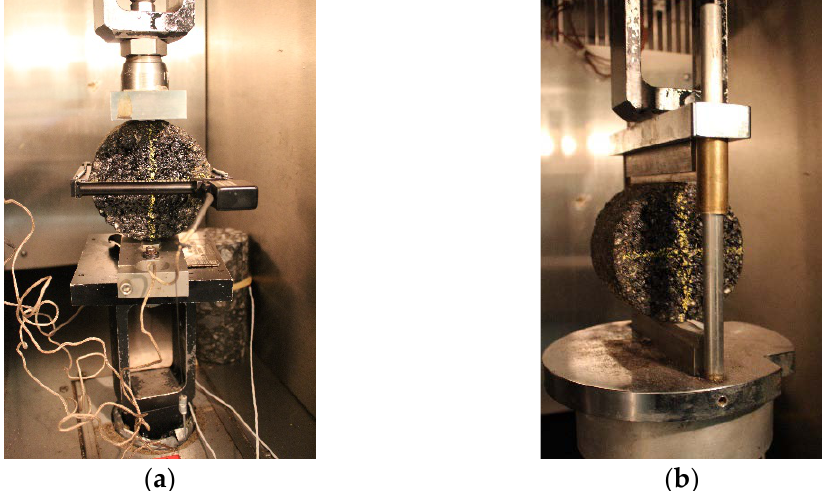
Figure 6. Asphalt performance evaluation: ( a ) ITSM device; ( b ) IDT device.